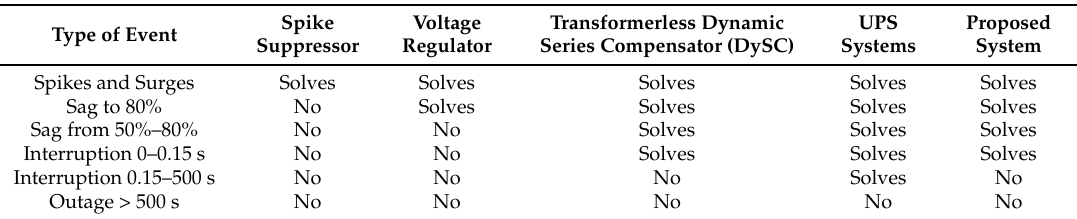
Table 1. Comparison of various conventional power conditioning equipment mentioned in [23] and proposed technique.